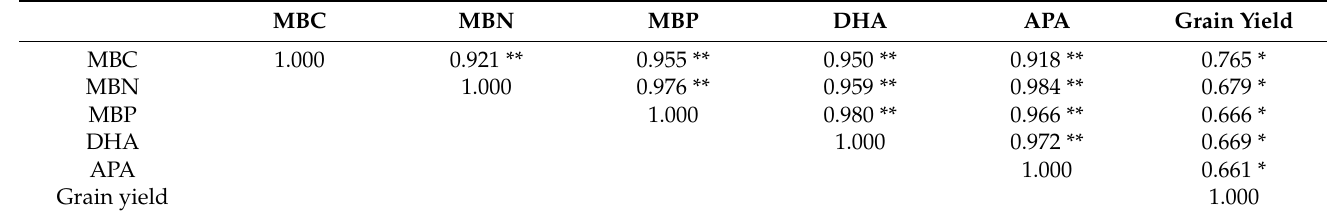
Table 4. Correlation coefficient between soil biological properties and grain